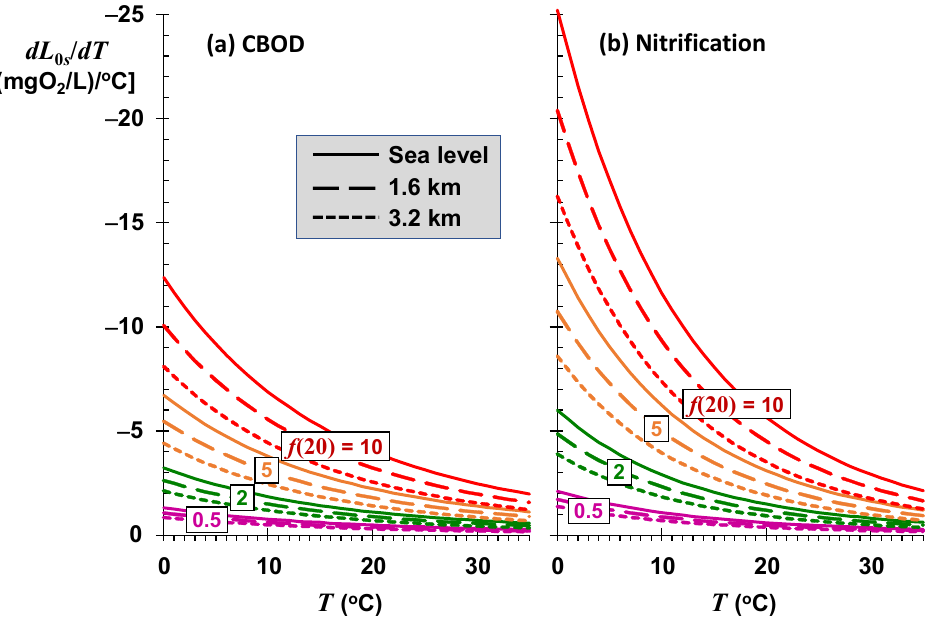
Figure 9. Plot of the temperature sensitivity of the sustainable mixing-point concentration as a function of temperature for freshwater rivers at several elevations and self-purification constants.